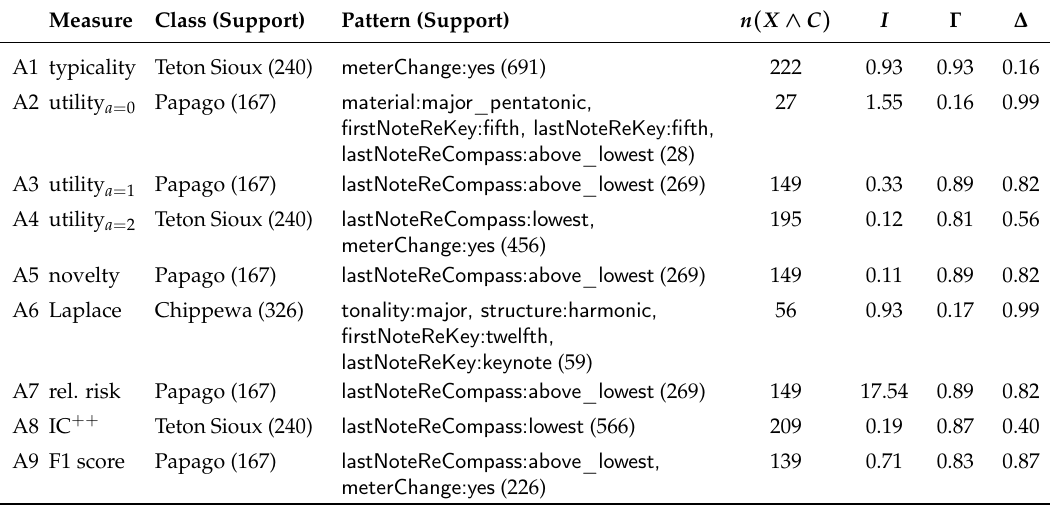
n ( C ) , pattern support count n ( X ) , association support count n ( X ∧ C ) , interestingness I (according to the respective interestingness measure), completeness Γ , and discriminant power ∆